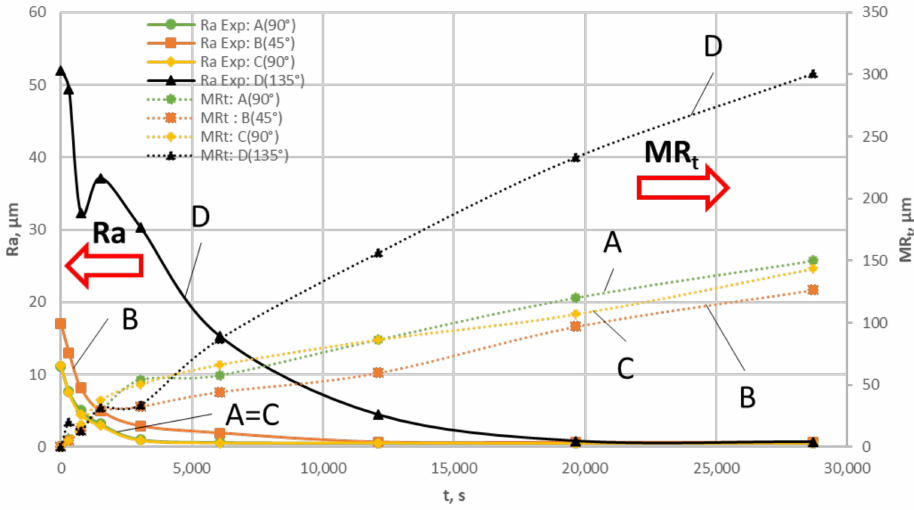
Figure A3. V-Shape As-Built: Ra ( t ) and MR t ( t ) [average